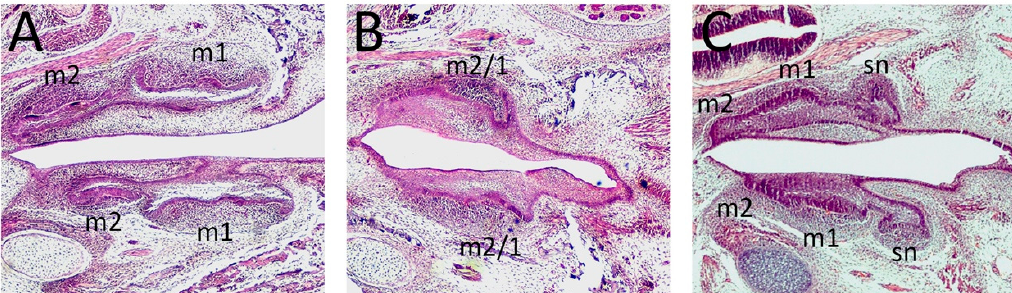
Figure 3. Disrupted Shh signaling and early tooth development. ( A – C ) Para-sagittal sections of the developing maxillary and mandibular molar dentition in ( A ) E16.5 Wild type; ( B ) E16.5 CreER™; Shh mutant; ( C ) E15.5 Gas1 mutant embryos. In the wild type embryo, the first molars (m1) are at the late cap/early bell stage of development and the second molars (m2) are at the early cap stage. In CreER™;